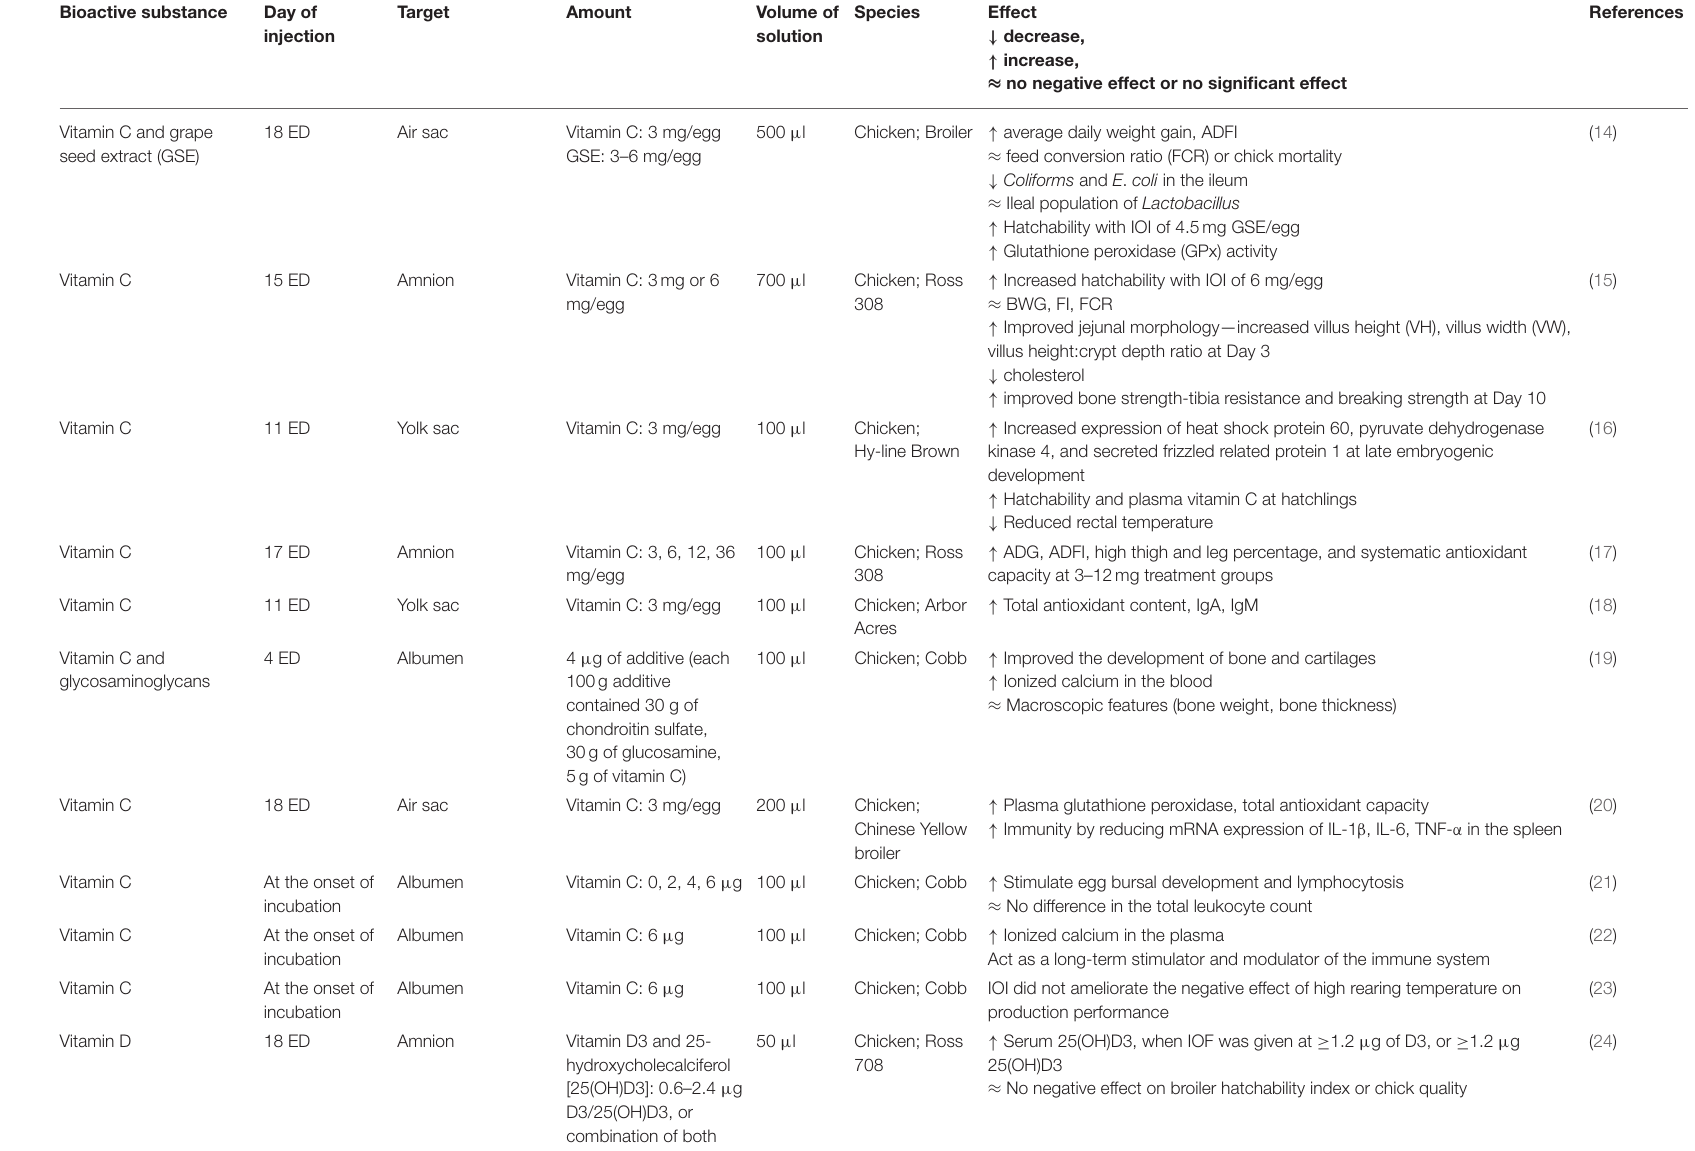
TABLE 1 | The effect of in ovo feeding of different biological compounds on performance and gut health variables of poultry. Bioactive